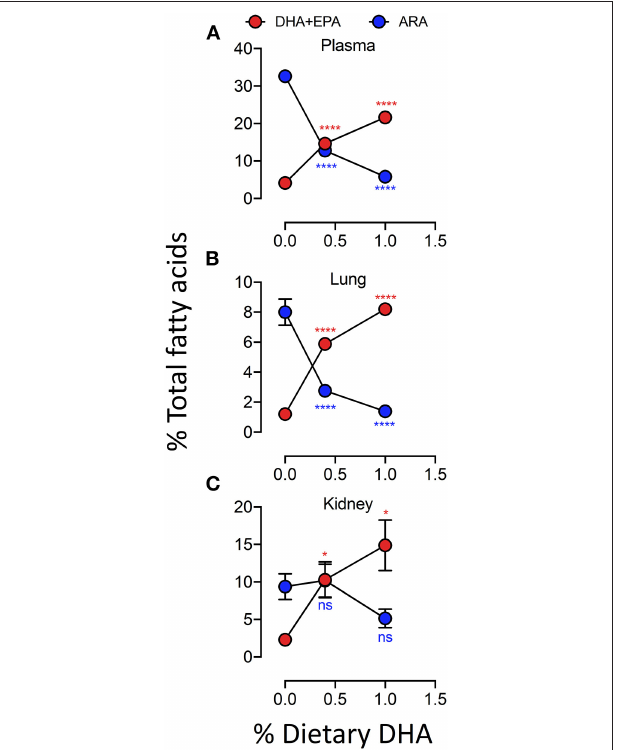
FIGURE 3 | Experimental diets influence the DHA and ARA concentrations in kidney, lung and plasma. Incorporation of EPA and DHA in the plasma (A) and tissues (B,C) increased in a dose-dependent manner that coincided with a reduction in ARA. Data presented as mean ± SEM. Fatty acid levels from animals fed the low-and high-DHA diets were compared to animals fed the CON diet. Statistical comparisons were performed as described in the Methods section. * p < 0.05, **** p < 0.0001, ns = not significant. Asterisk/text color corresponds to fatty acid data being analyzed (ARA, red; EPA + DHA,